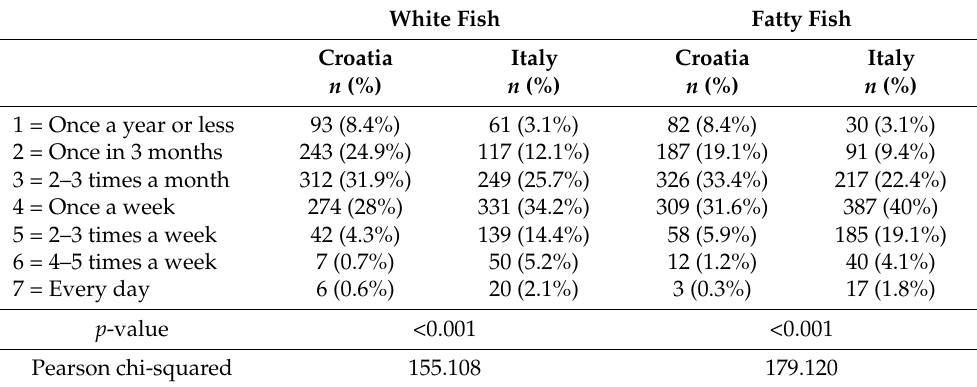
Table 2. Frequency of consumption of white and fatty fish in study participants in Croatia and Italy. White Fish Fatty